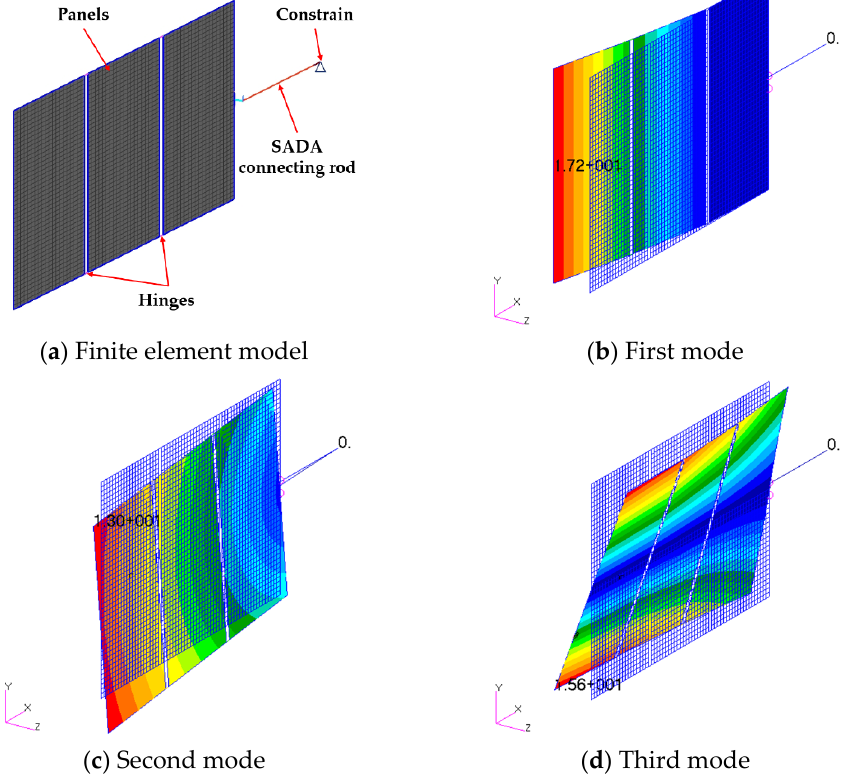
Figure 5. Finite element model and the first three modes of the solar array.